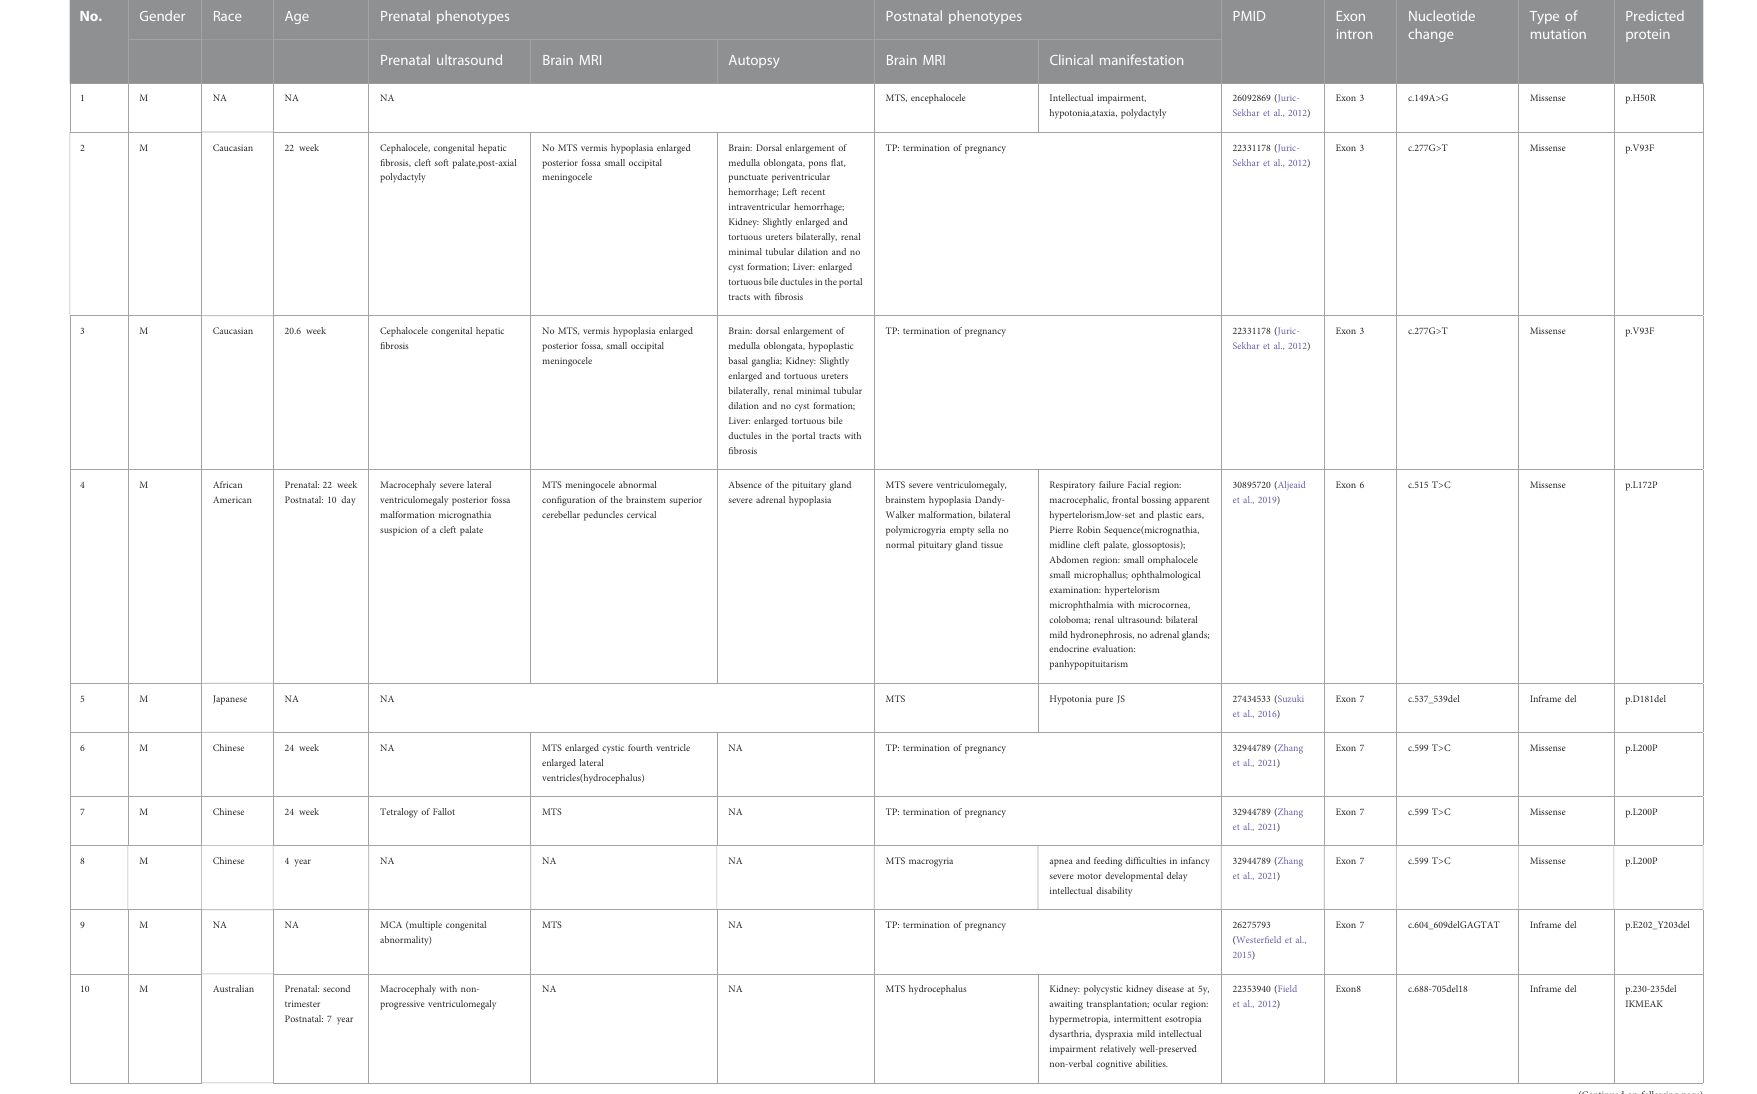
TABLE 2 Prenatal and postnatal features of individuals with previously described OFD1 variants in JBS10 (including the individuals in this study).